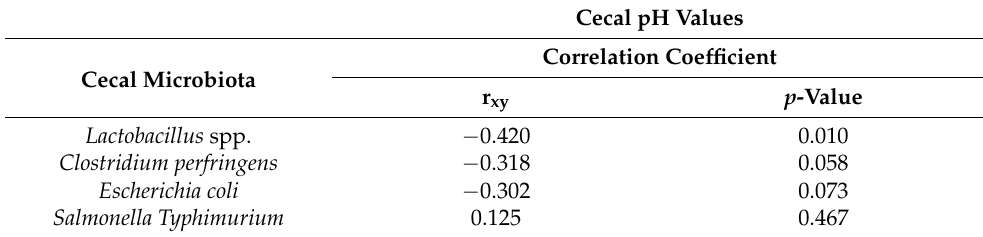
Table 8. Pearson correlation between cecal pH and bacterial populations. Cecal Microbiota